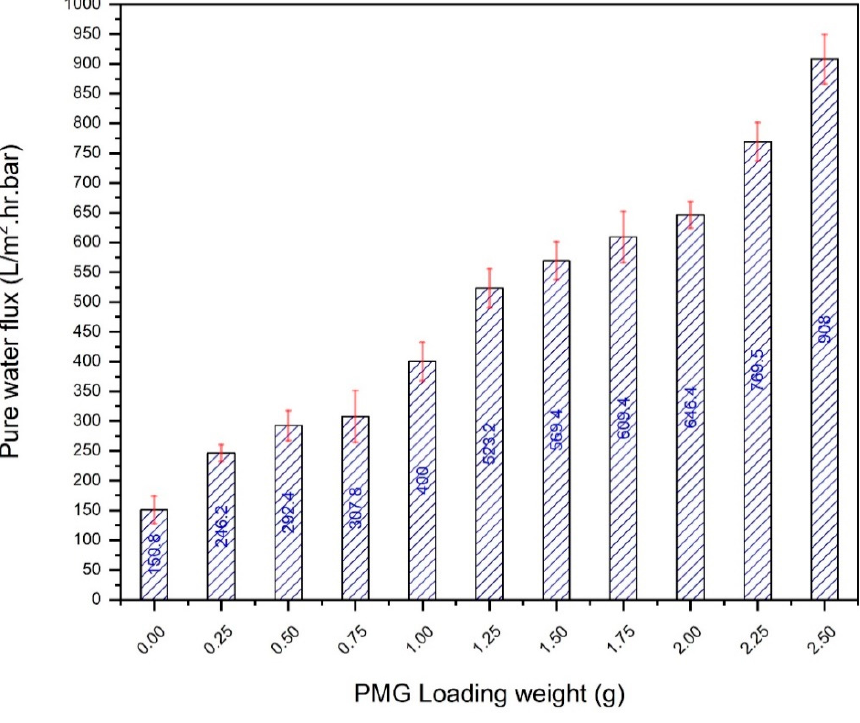
Figure 11. Pure water flux of all pristine and PMG-modified membranes.